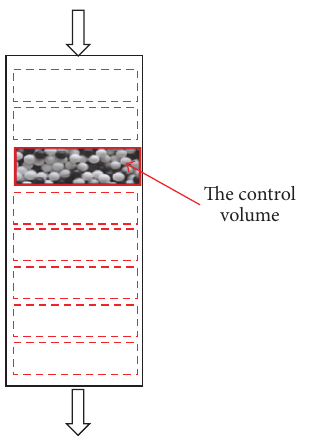
Figure 1: Schematic of CIADS.